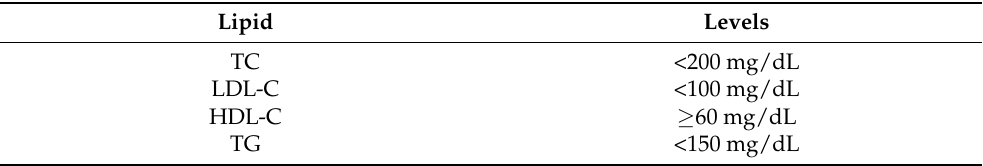
Table 1. Desirable blood lipid levels for total cholesterol (TC), low-density lipoproteins (LDL-C), high-density lipoproteins (HDL-C), and triglycerides (TG) [32,33]. All lipid levels are measured in milligrams per deciliter